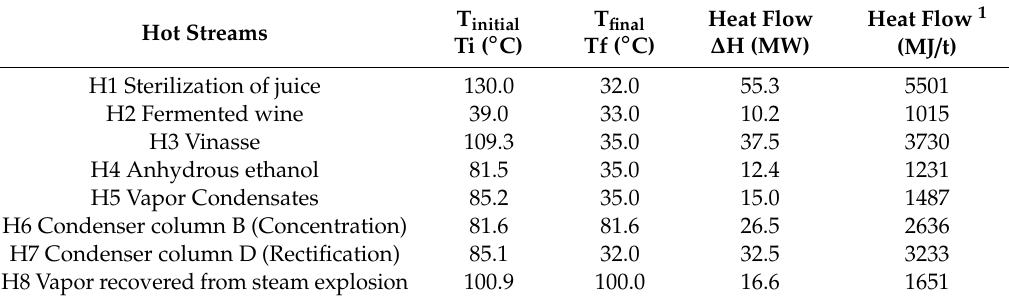
Table A9. Streams selected for heat